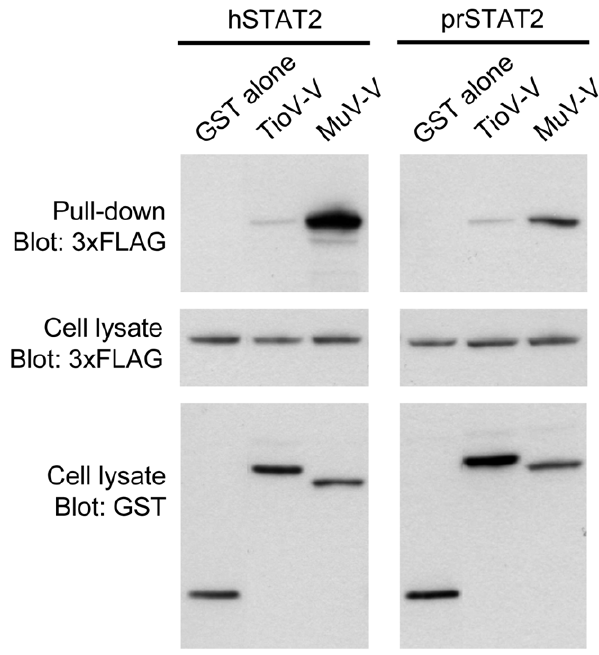
Figure 9. TioV-V fails to interact with Pr STAT2. HEK-293T cells were co-transfected with expression vectors encoding GST alone or fused to TioV-V or MuV-V (500 ng/well), and pCI-neo-3xFLAG expression vectors (300 ng/well) encoding for 3xFLAG-tagged STAT2 from human (hSTAT2) or Pteropus rodricensis ( Pr STAT2). Total cell lysates from transfected cells were prepared 48 h post-transfection (cell lysate; middle and lower panels), and protein complexes were assayed by pull- down using glutathione-sepharose beads (GST pull-down; upper panel). 3xFLAG- and GST-tagged proteins were detected by immunoblotting.